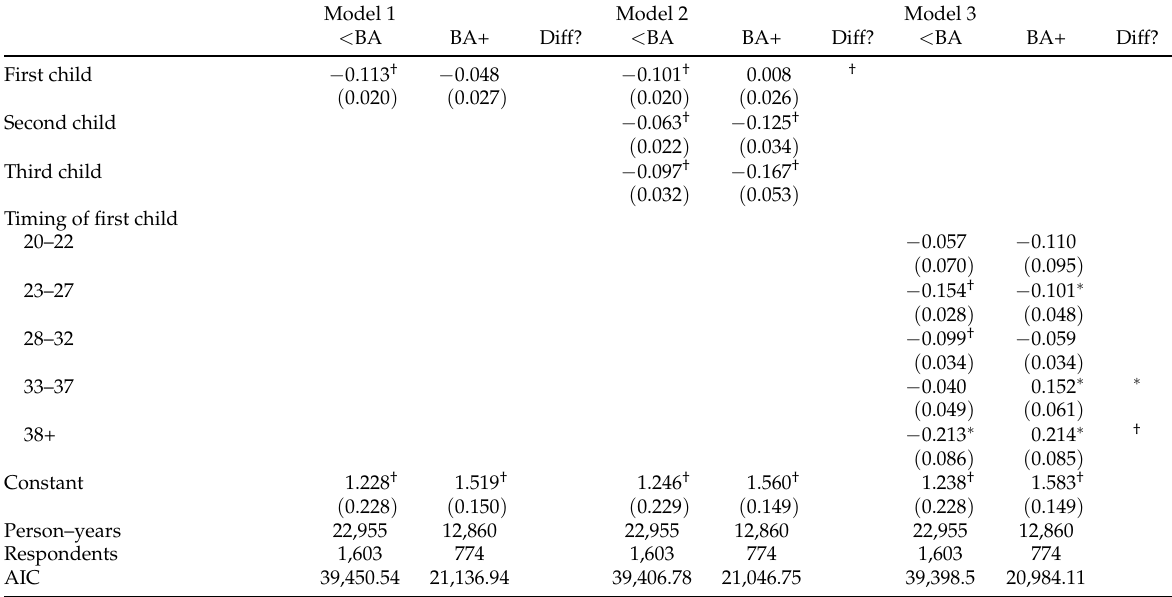
Table 2: Fixed-effects estimates of motherhood, parity, and timing on log wages by